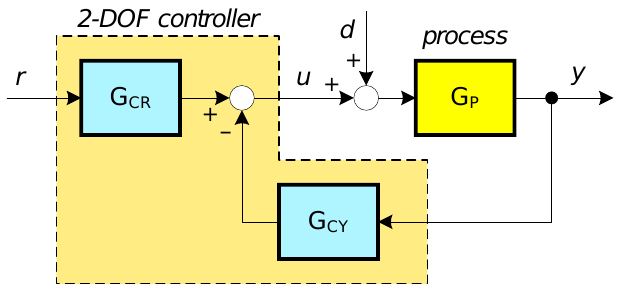
Figure 2. 2-DOF controller structure used in equalization method.